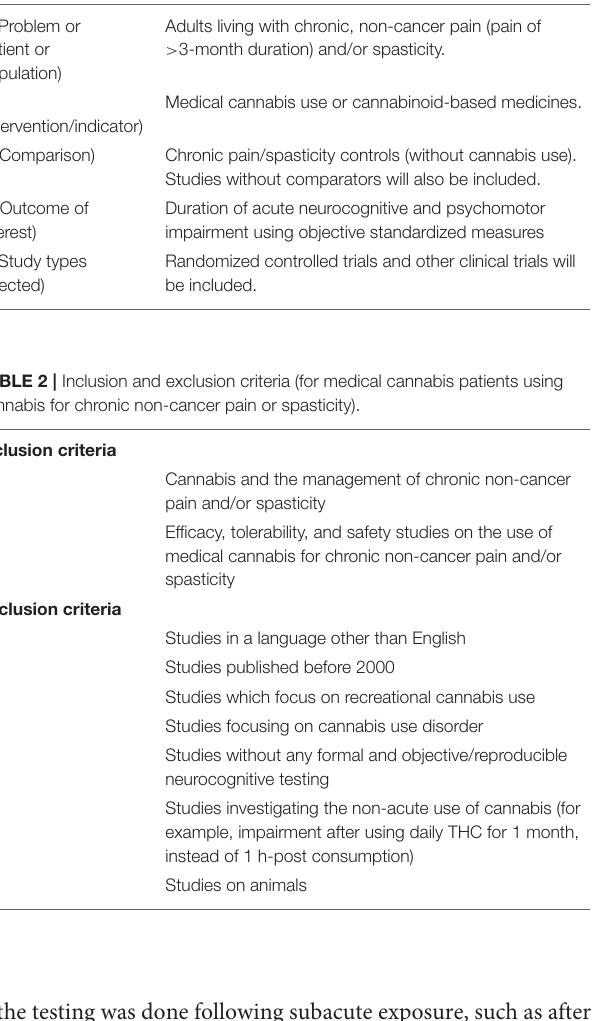
TABLE 1 | PICOS breakdown of study eligibility criteria.